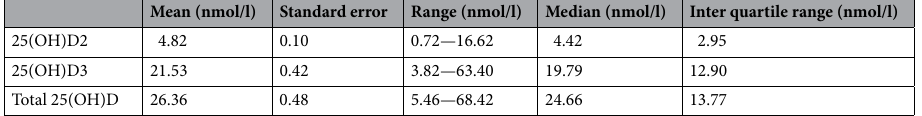
Table 1. Descriptive summary of the mean serum 25(OH)D